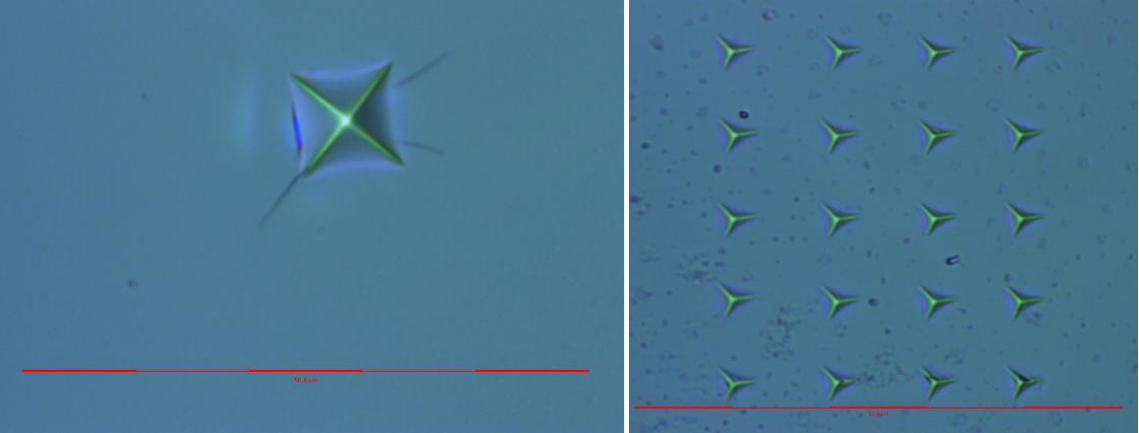
Fig. 7 To the left, example of Vickers indenter imprint in commercial float glass 0.5 N. To the right, example of Berkovich imprints in commercial microscope slide 50